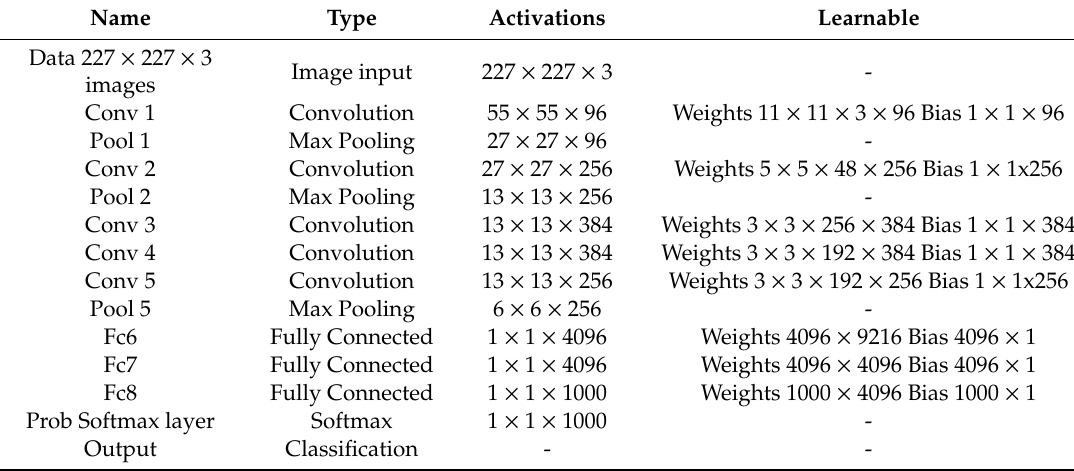
Table 4. AlexNet